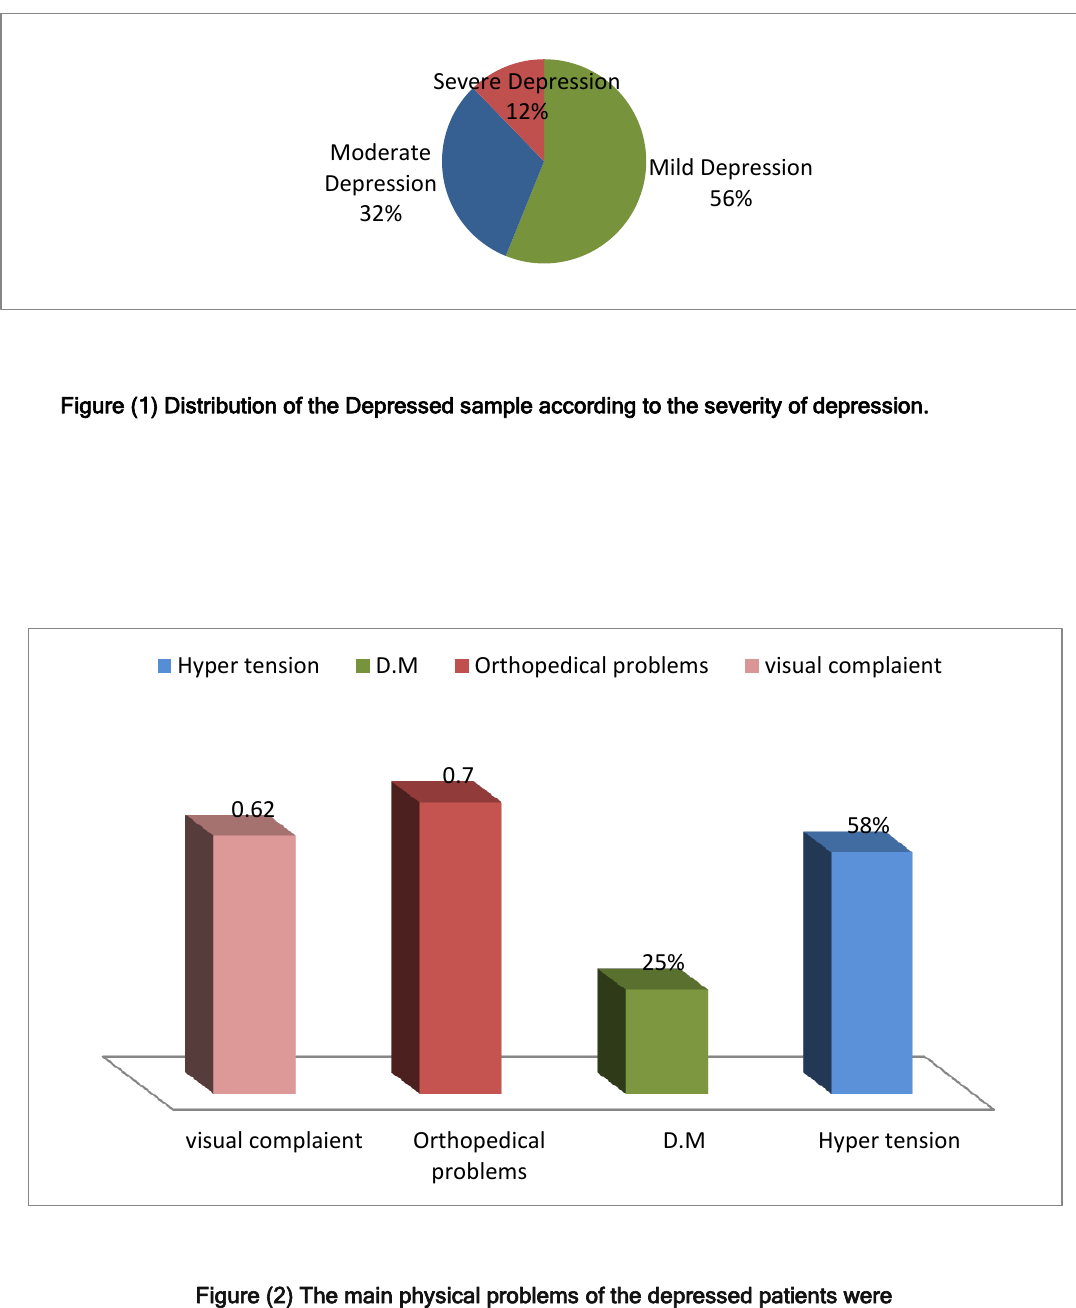
Figure (2) The main physical problems of the depressed patients were ( Orthopedical , Visual complaints , Hypertension ,